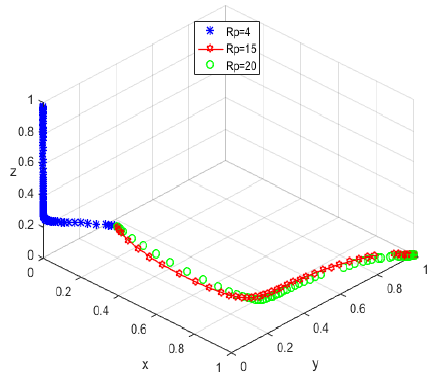
Figure 7. Trend graph for R P .